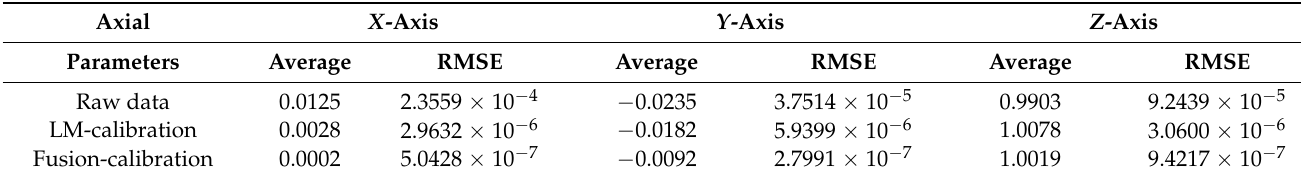
Figure 8. Comparison of original sensor, calibrated single MEMS, and fused calibrated MEMS in MEMS0 gyroscope at standstill: ( a ) X -axis of the gyroscope; ( b ) Y -axis of the gyroscope; ( c ) Z -axis of the gyroscope. Table 8. MEMS0 gyroscope performance parameter ratio chart. Table 7. MEMS0 accelerometer performance parameter ratio graph.